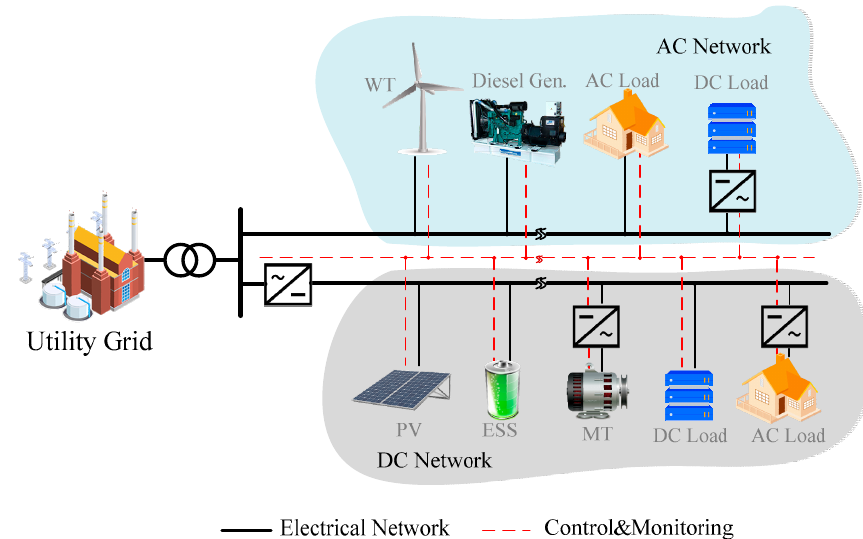
Figure 1. Configuration of a typical hybrid AC/DC MG.